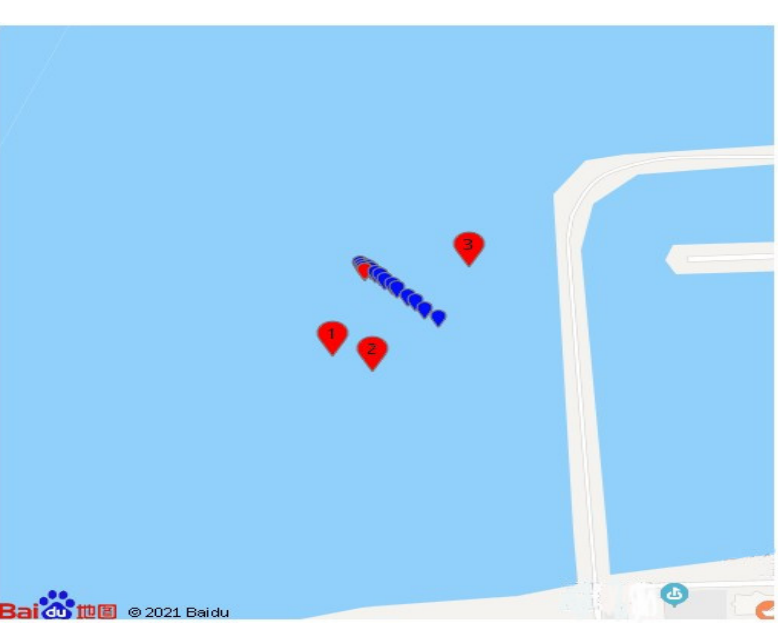
Figure 19. Signal trajectory